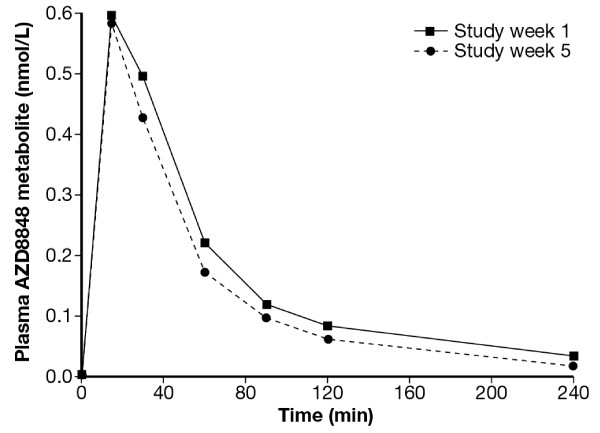
Mean plasma levels of AZD8848’s acid metabolite from the first group of the repeat challenge/treatment study after administration of 60 μg of the study drug. The metabolite increased rapidly and returned to baseline levels after four hours.